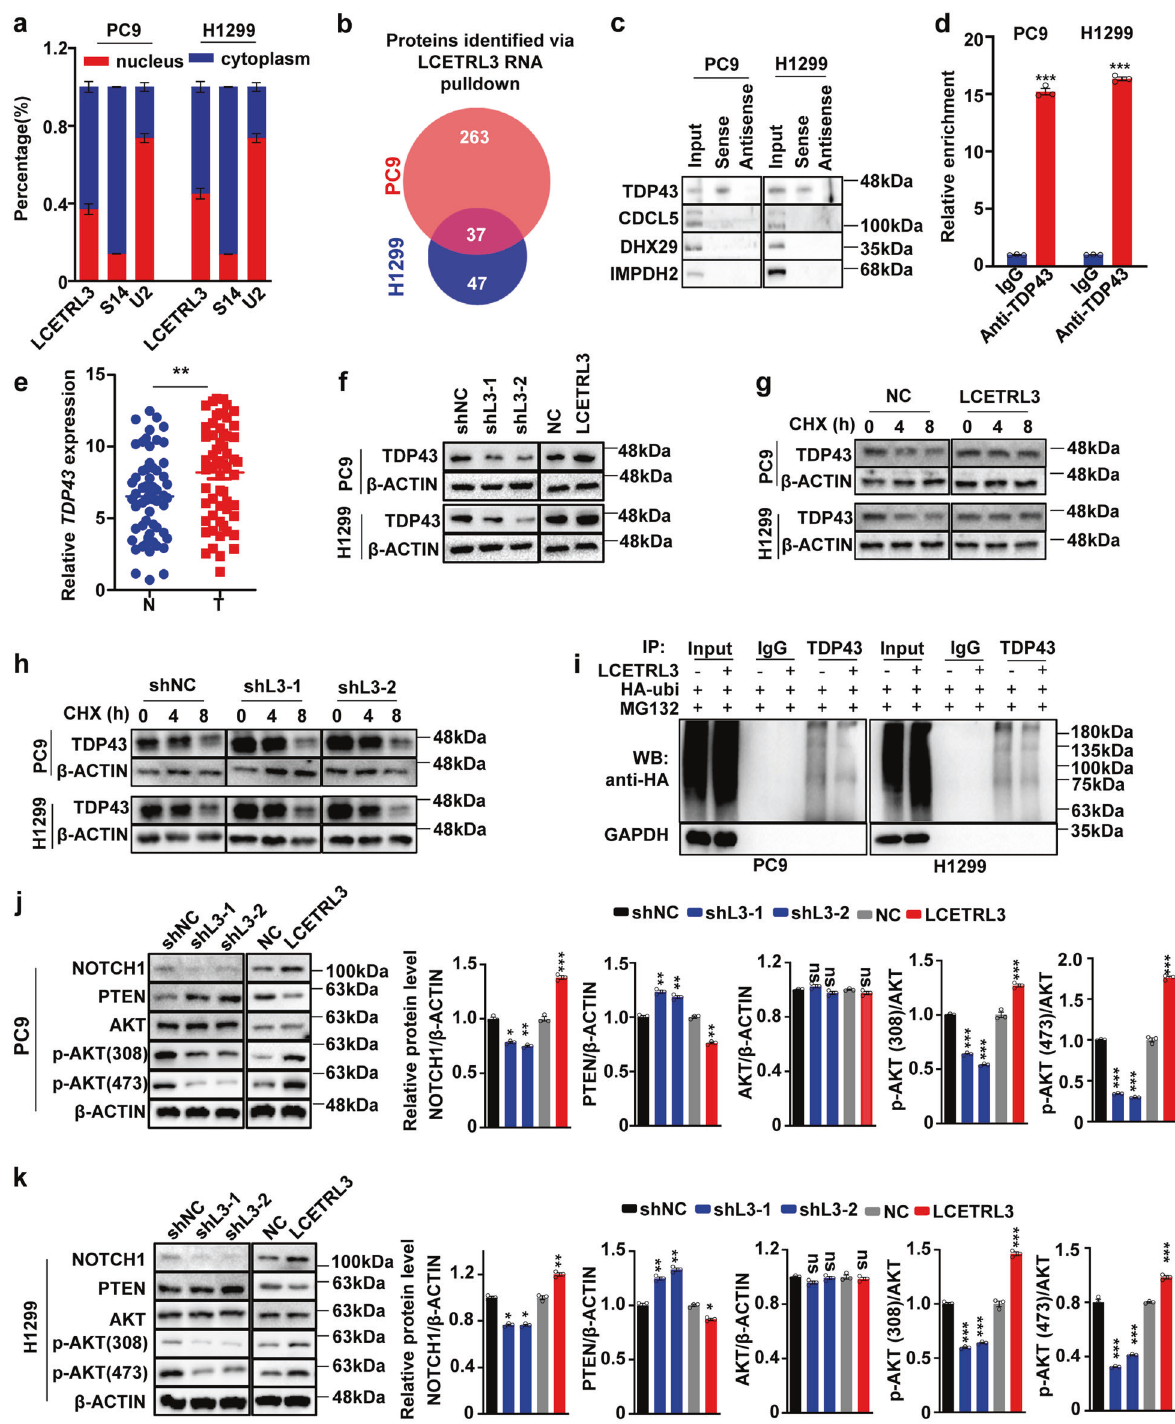
Fig. 4 LncRNA LCETRL3 interacted with TDP43, prevented TDP43 degradation and activated the AKT signaling. ( a ) Cellular location of LCETRL3 in NSCLC PC9 and H1299 cells. ( b ) LCETRL3 pulldown proteins were identi fi ed by mass spectrometry in PC9 and H1299 cells. ( c ) Western blot validation of TDP43 pulled down by lncRNA LCETRL3. ( d ) LCETRL3 could be precipitated with antibody against TDP43 as compared with the IgG control in PC9 and H1299 cells. Relative enrichment (means ± SD) represents lncRNA LCETRL3 levels precipitated with TDP43 relative to an input control from three independent experiments. ( e ) There was markedly increased TDP43 expression in NSCLC tissues compared to normal tissues of the combined samples in the Discovery and Validation cohorts ( n = 64). ( f ) The TDP43 protein levels in PC9 and H1299 cells after either silencing of LCETRL3 or over-expressing LCETRL3 without any treatments. ( g, h ) Western blot analyses of TDP43 protein levels in PC9 and H1299 cells with stable over-expressed or silenced LCETRL3 after treatment of cycloheximide (CHX). ( i ) Western blot analyses of the ubiquitination of TDP43 in PC9 and H1299 cells that stabilized either silenced LCETRL3 or over-expressed LCETRL3. ( j, k ) LCETRL3 obviously upregulated NOTCH1 expression, suppressed PTEN expression and promoted phosphorylation of AKT in PC9 cells ( j ) and H1299 cells ( k ). Two- tailed unpaired t test, ns, not signi fi cant, * P < 0.05, ** P < 0.01, *** P < 0.001 Signal Transduction and Targeted Therapy (2022)